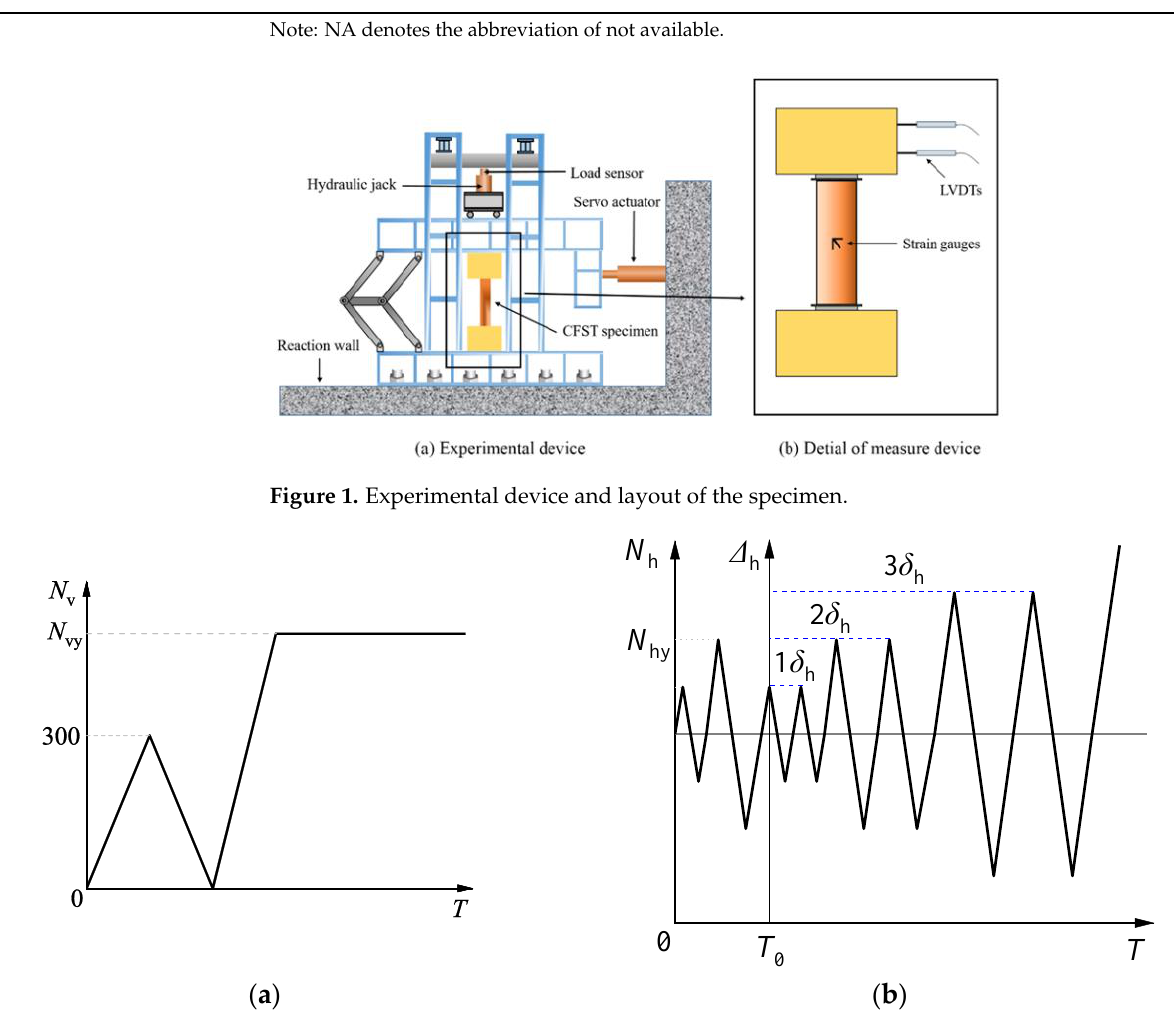
Figure 2. Loading system of specimens. ( a ) Vertical loading system; ( b ) Horizontal loading system.